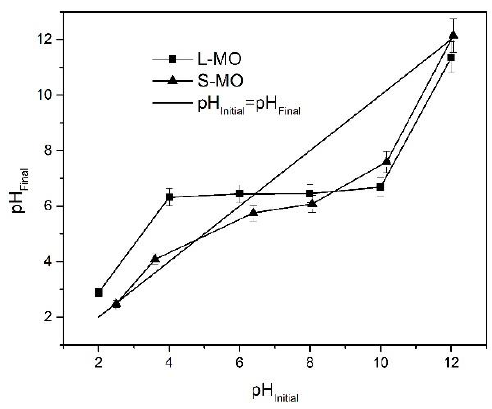
Figure 1. pH PZC of L-MO and S-MO biosorbents.